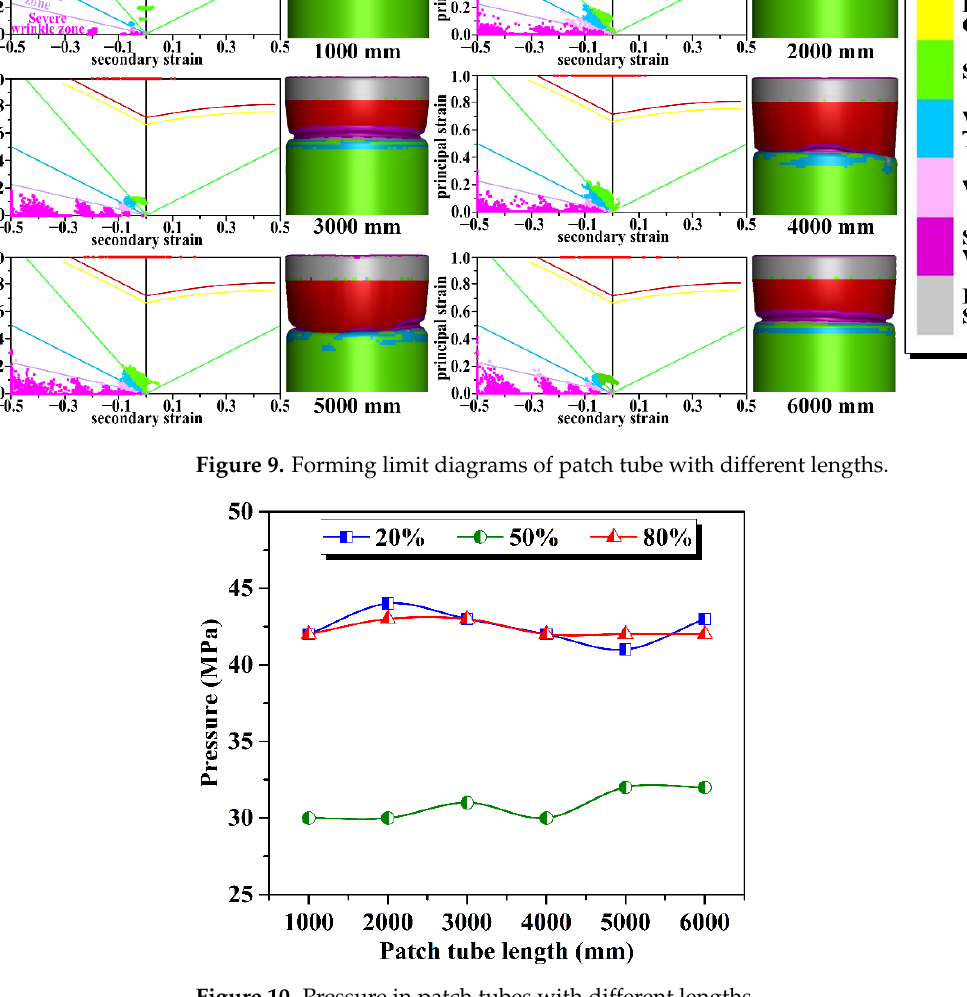
Figure 10. Pressure in patch tubes with different lengths.